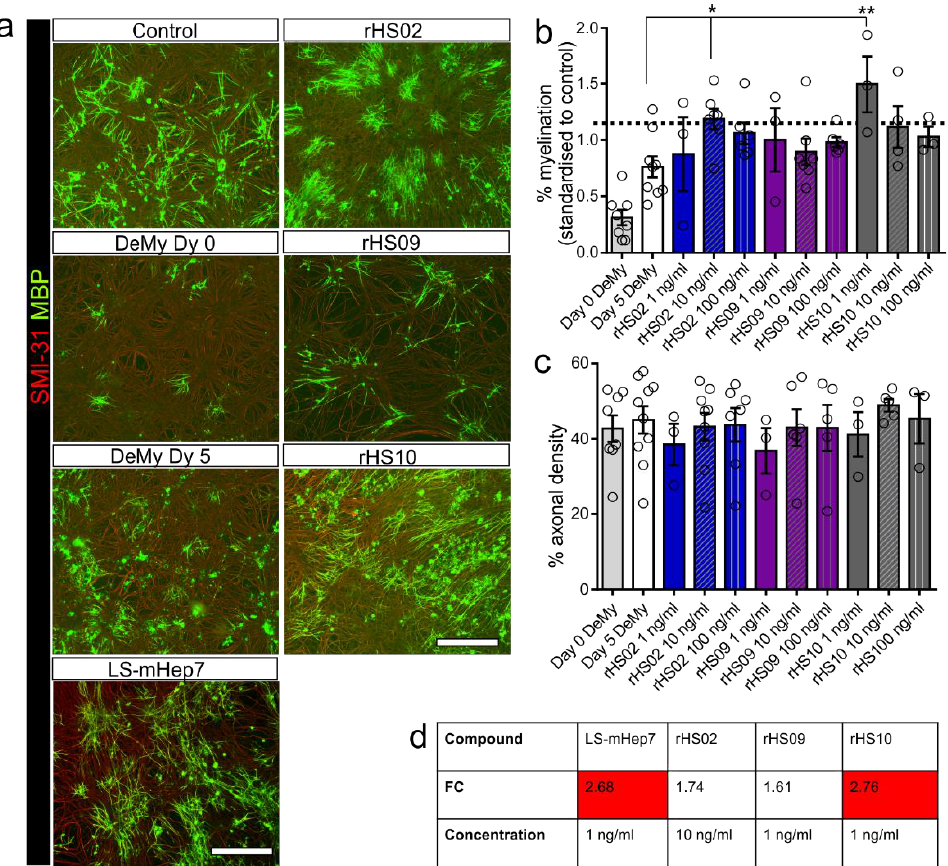
Figure 1. Effect of rHS02, rHS09 and rHS10 on in vitro remyelination after MOG and complement induced demyelination. Myelinating cultures at 24 DIV were demyelinated by overnight treatment with MOG (Z2) antibody and rabbit complement (termed MC-DeMy after demyelination). The following day all media was removed, and cultures treated with either, rHS02, rHS09 or rHS10 at 1, 10 or 100 ng/mL or left untreated as control. 5 DIV post treatment, cultures were fixed and stained to assess the level of remyelination. ( a ) Representative images of control untreated cultures, those after overnight demyelination (DeMy Dy 0), or 5 DIV post demyelination (DeMy Dy 5), or after 5 DIV post treated with LS-mHep7, rHS02, rHS09 and rHS10 at 10 ng/mL. SMI-31 stains axons in red, MBP stains myelin sheath in green. Scale bar represents 50 µ m. ( b ) Graph shows quantification of % myelination. rHS02 at 10 ng/mL and rHS10 at 1 ng/mL significantly promoted remyelination. The average level of remyelination produced by LS-mHep7 at 1 ng/mL is illustrated by the demarcated dashed line. ( c ) Graph shows quantification of % axonal density showed no significant effects of any of the compounds tested. ( d ) Table details the average FC in remyelination compared to Day 5 DeMy cultures. LS-mHep7 and rHS10 both increase remyelination to a similar level. ( n number represented by individual circle data points on the graph, ANOVA with Dunnett’s post-test, * p < 0.05, ** p < 0.01).